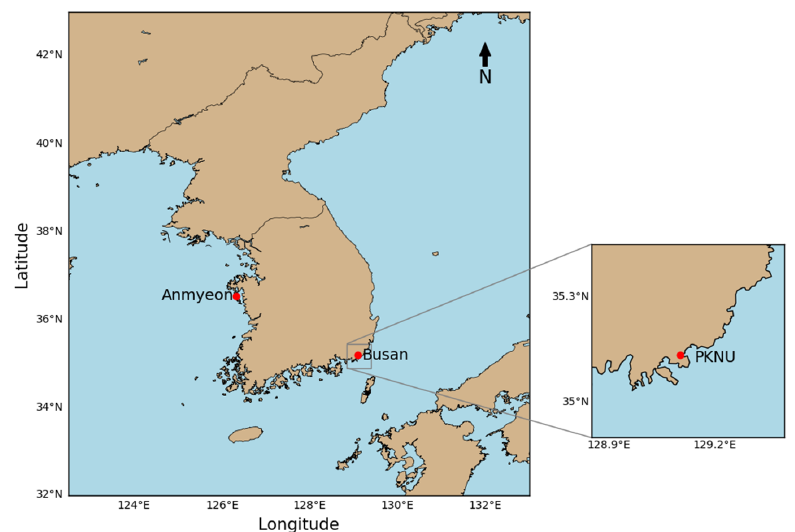
Figure 1. Location of the intensive observation site. PKNU, Pukyong National University. The APS monitors velocity according to the size of the particles flowing into the measuring module. This module is composed of the particle acceleration nozzle and light scattering device capable of detecting avalanche photodetector scatter to measure the concentration of each particle size. The APS observes the aerosol number concentration every 3 min for 52 size channels, for particle diameters ranging from 0.5 to 20.0 µ m. Sample and external flow rates were 1 L · min − 1 and 4 L · min − 1 , respectively, with a measurement uncertainty of approximately ± 10%